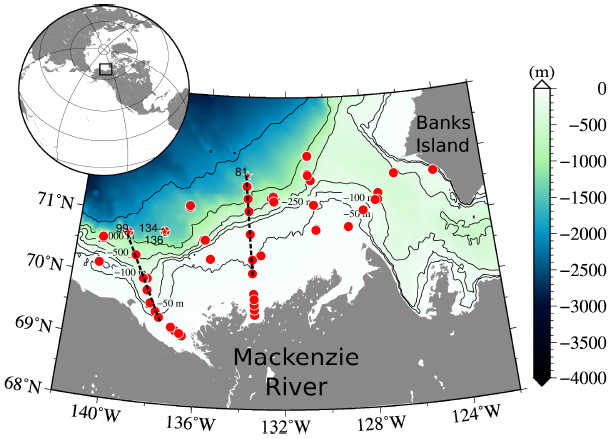
Fig. 1. Location of sampling stations for the MALINA cruise in the Southern Beaufort Sea, Canadian Arctic. Three deep stations (bottom depth > 1000m) were selected to show typical hydrography of the Arctic Ocean (stars). One profile at station 310 (cast # 81) and 620 (cast # 99) each and three profiles at station 540 (cast # 134– 136) are shown in Fig. 3. Two black and dashed lines represent west and east channels of the Mackenzie river. Vertical sections along those lines are shown in Fig.